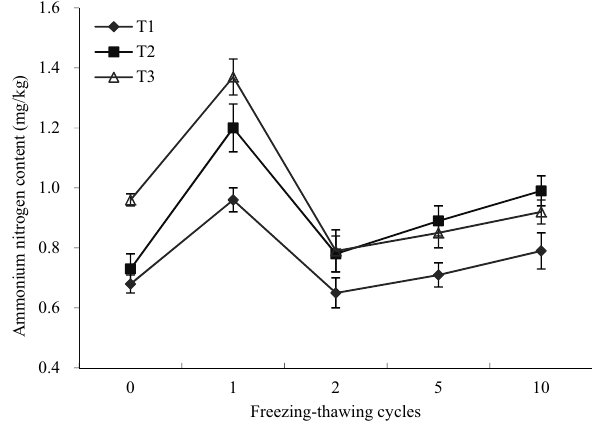
Figure 3: Changes of ammonium nitrogen content in reconstituted soil with di ff erent freezing – thawing